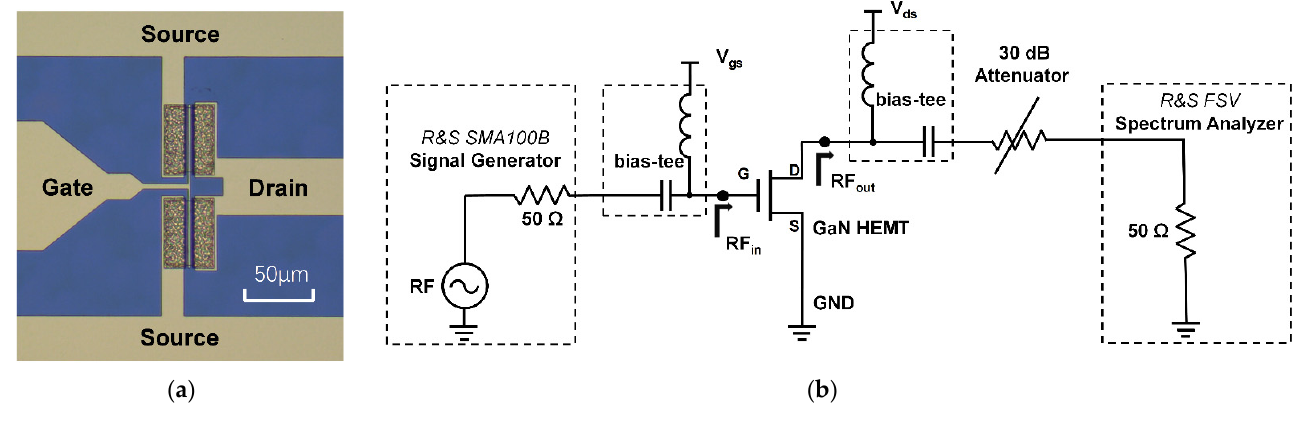
Figure 1. ( a ) Micrographs of GaN HEMT grown and fabricated on SiC with GSG test module; ( b ) the test setup of this HEMT RP experiment diagram.